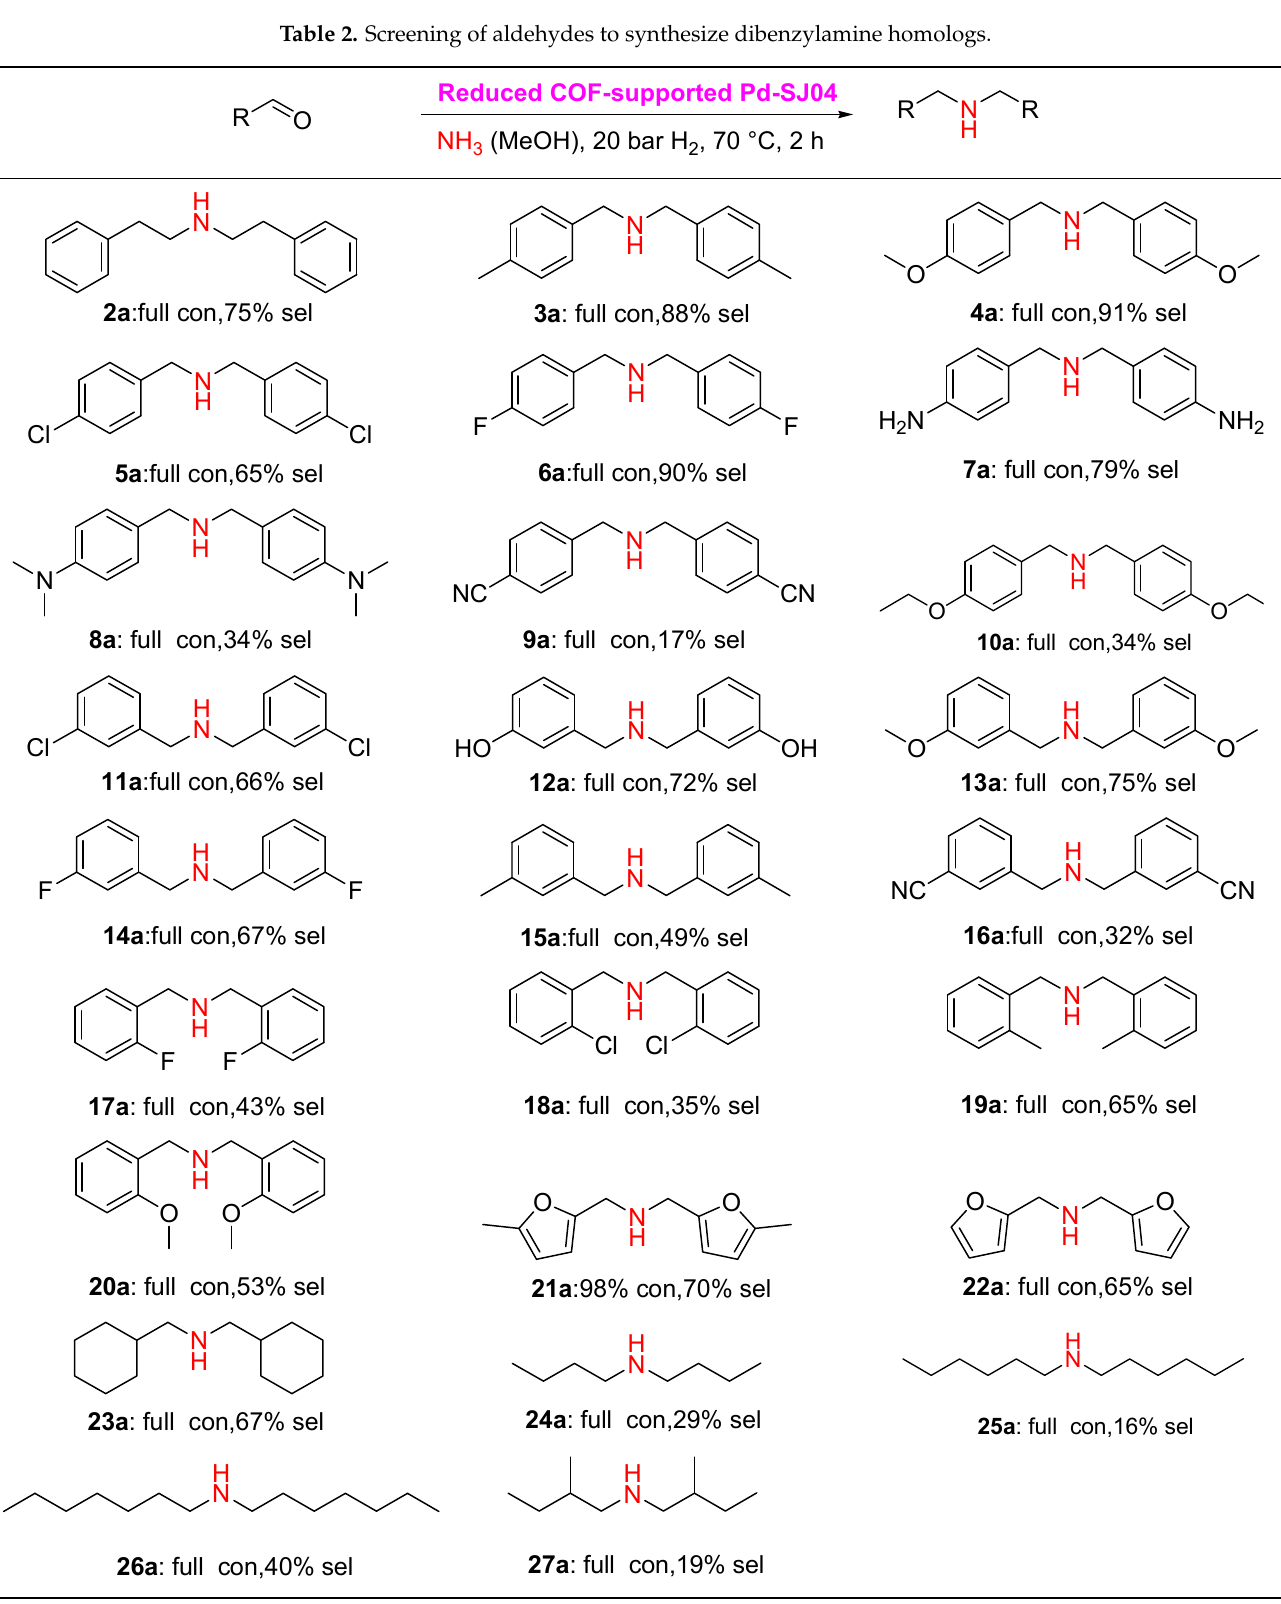
Reaction conditions: 5 mg catalyst, 0.5 mmol aldehydes, 5 mL Methanol ammonia solution. Yields and conversions were determined by GC with the internal standard.